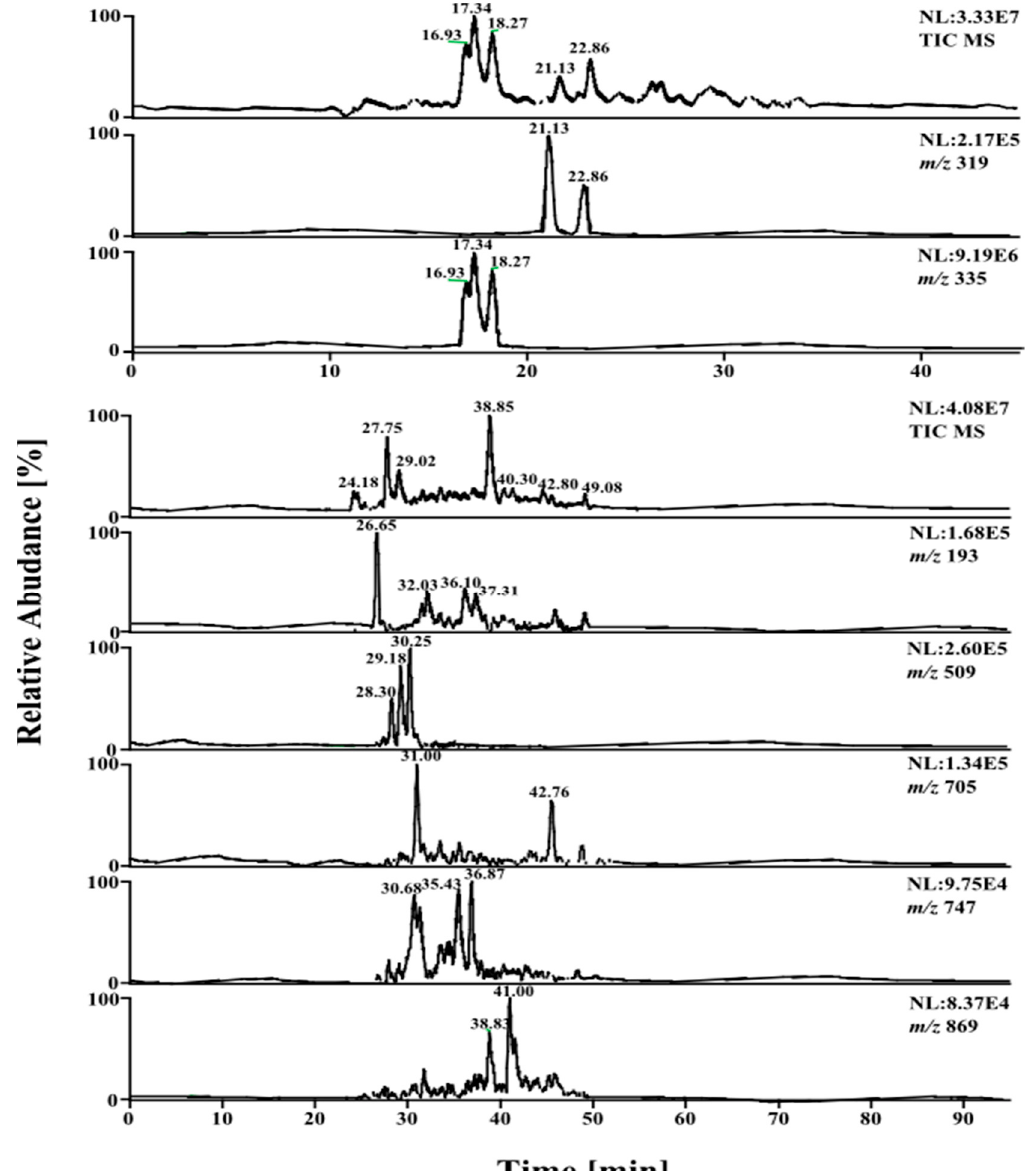
Figure 1. LC-ESI-MS-TIC and reconstructed ion chromatograms (RICs) (negative ion mode, base peak in the range 150–2000 m / z ) of the phenolic compounds in male flowers of date palm.